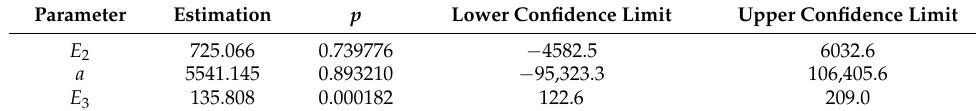
Figure 8. Fragment of the model of analyzed exploration field with marked division of pillars.